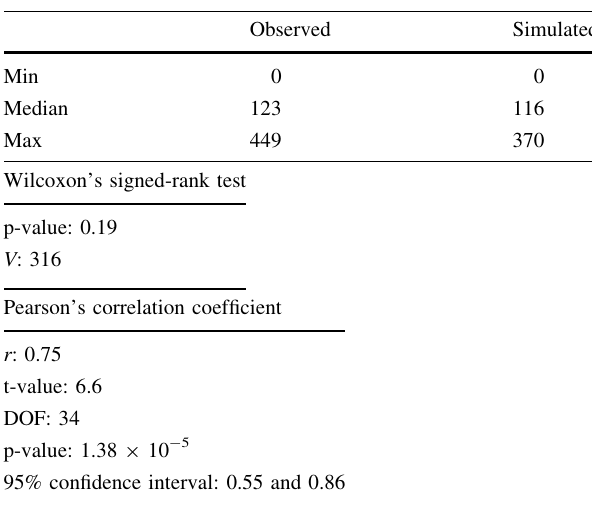
Table 2 Results of test of difference in median lanes and Pearson’s correlation coefficient between observed and simulated interaction